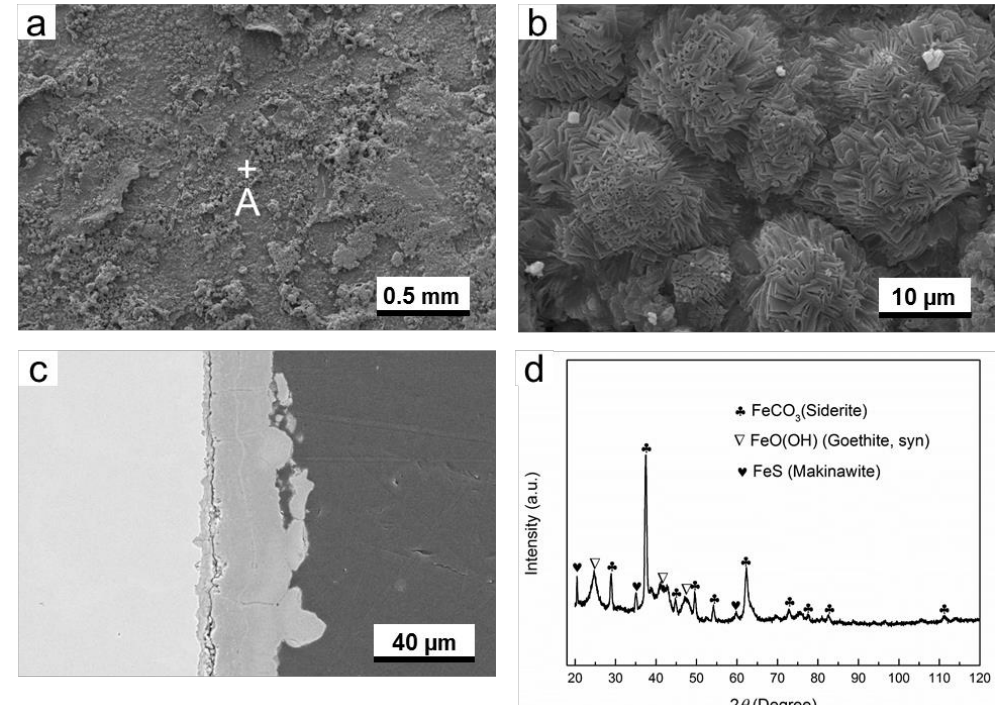
Figure 6. The characterization of corrosion products on G20 steel in gas phase in H 2 S-containing environment: ( a ) SEM image of the surface of corrosion products; ( b ) the higher magnification of region A marked in ( a ); ( c ) corrosion-sectional image of corrosion product layer, and ( d ) XRD pattern of the corrosion products.